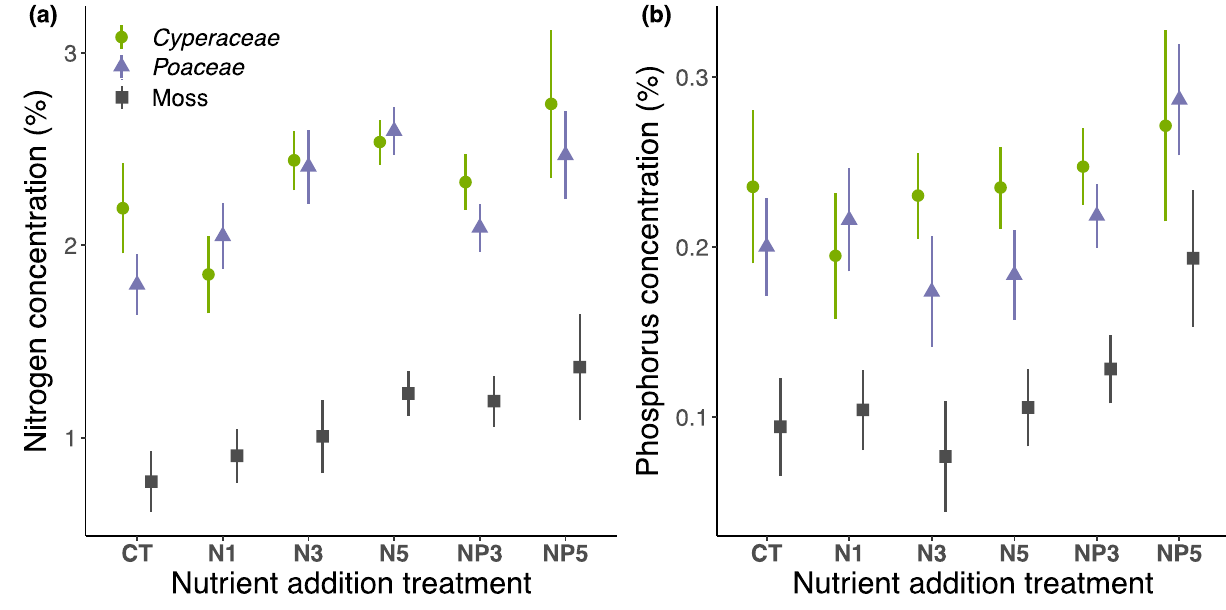
Figure 5. ( a ) Nitrogen concentration and ( b ) phosphorus concentration of leaves and stems according to fertilization treatments and taxonomic groups after 17 years of experimentation in the tundra wetlands at Bylot Island, Nunavut. Least square means ± SE are presented. See methods for definition of